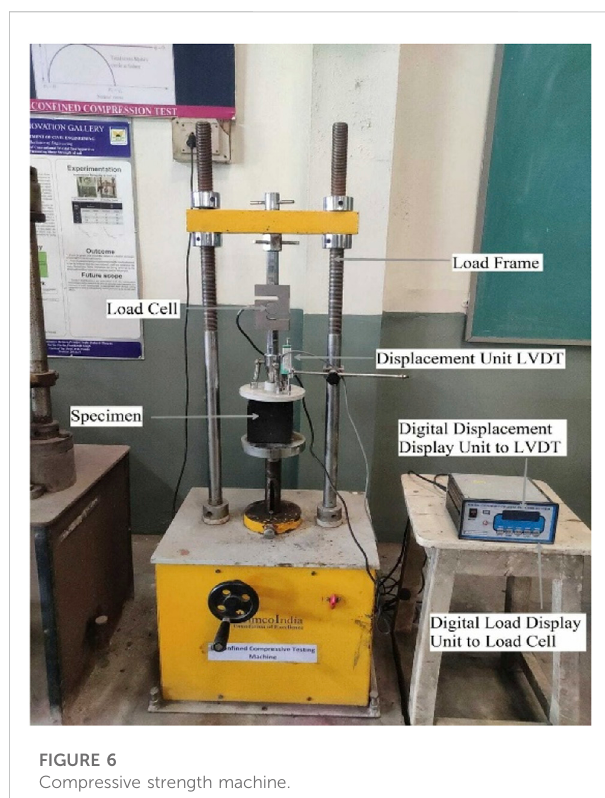
FIGURE 6 Compressive strength machine.